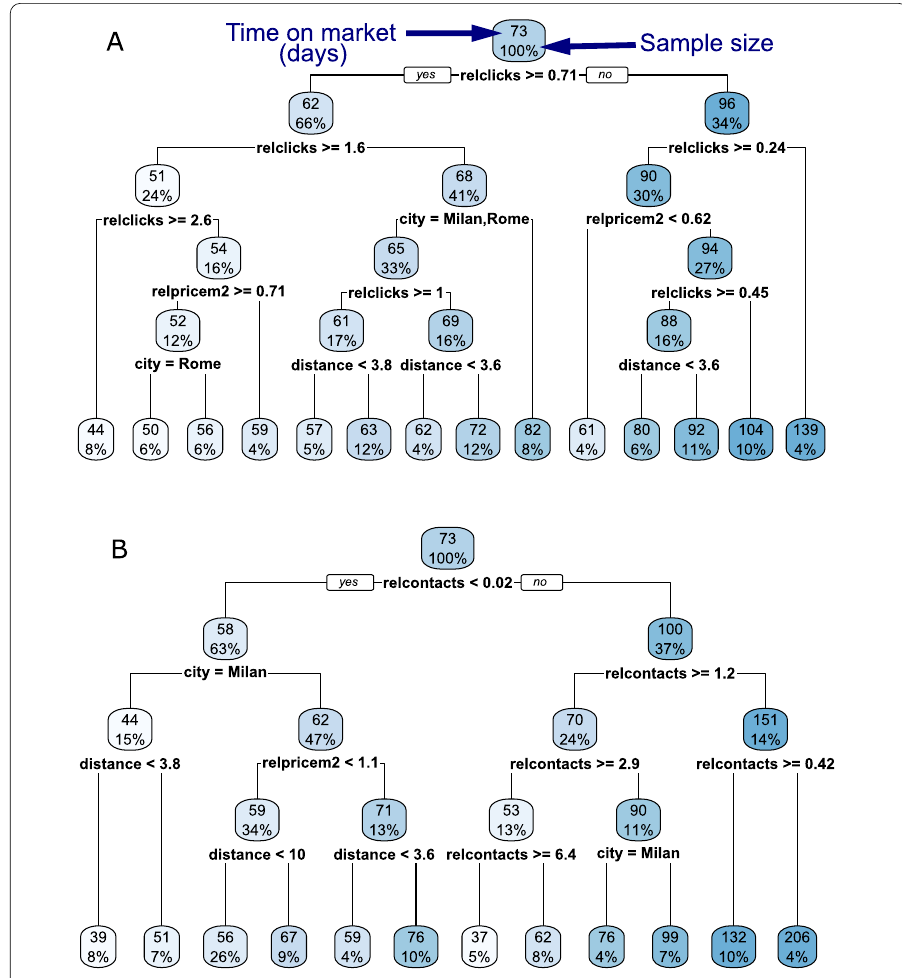
Figure 7 Regression trees quantifying variable importance in the determination of the time on market. For each node, the number on top is the average time on market (in days), and the percentage below is the sample size in that node. Nodes are colored in darker shades of blue for longer time on market. From each node, the edge to the left is a TRUE to the condition, while the edge to the right is a FALSE. ( A ) The relative number of clicks is by far the most important variable because it determines the first splits. It is followed by geographical and price variables. Higher number of clicks (edges to the left) predicts shorter time on market. ( B ) The first split distinguishes between ads that received no contacts (left branch), and ads that received at least one (right branch). In the right branch, contacts are the most important variable. The figure has been generated using R package